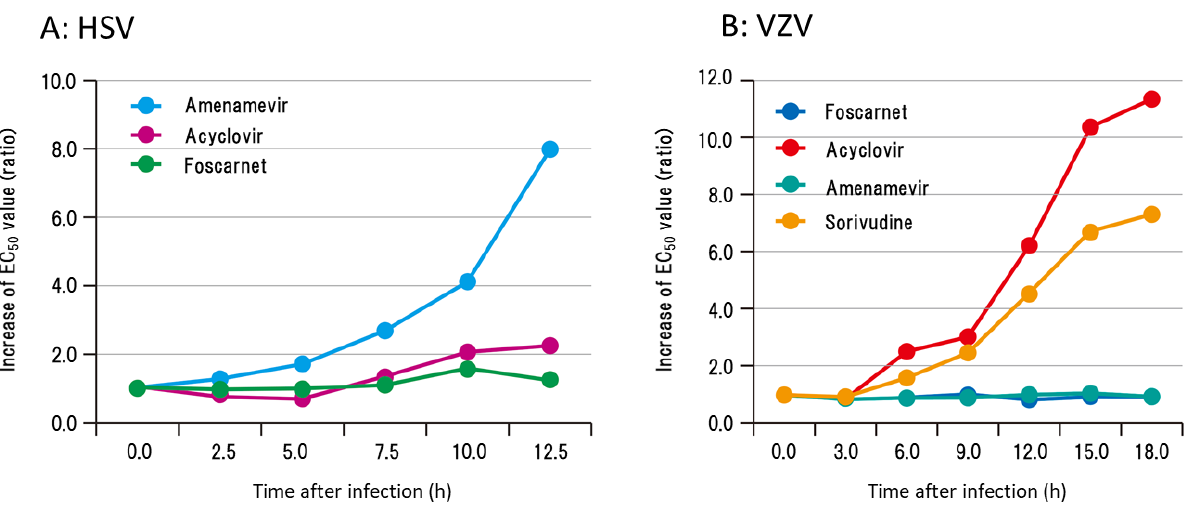
Figure 4. Time course of changes in susceptibility of HSV- and VZV-infected cells to acyclovir, amenamevir, foscarnet, and sorivudine [17,18]. The susceptibility of ( A ) HSV- and ( B ) VZV-infected cells to acyclovir, amenamevir, foscarnet, and sorivudine was assessed serially after infection to examine when and how the susceptibility of infected cells to antiviral drugs might change during the replication cycle of HSV and VZV. EC 50 values of infected cells to anti-herpetic drugs were determined at the indicated times after infection, and the increase in EC 50 values is expressed as the ratio of those at 0 h. The authors obtained permission from Antiviral Research to reuse these figures